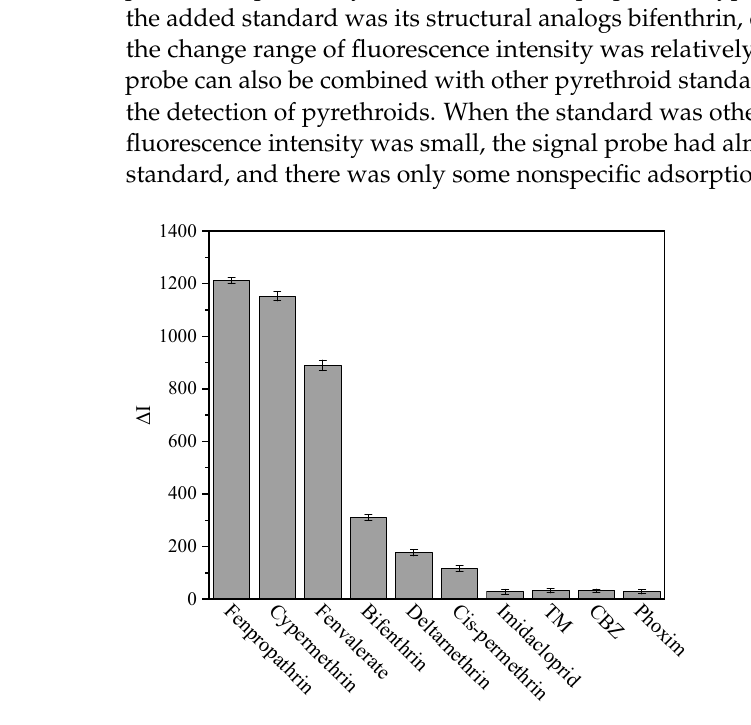
Figure 7. Cross reaction.